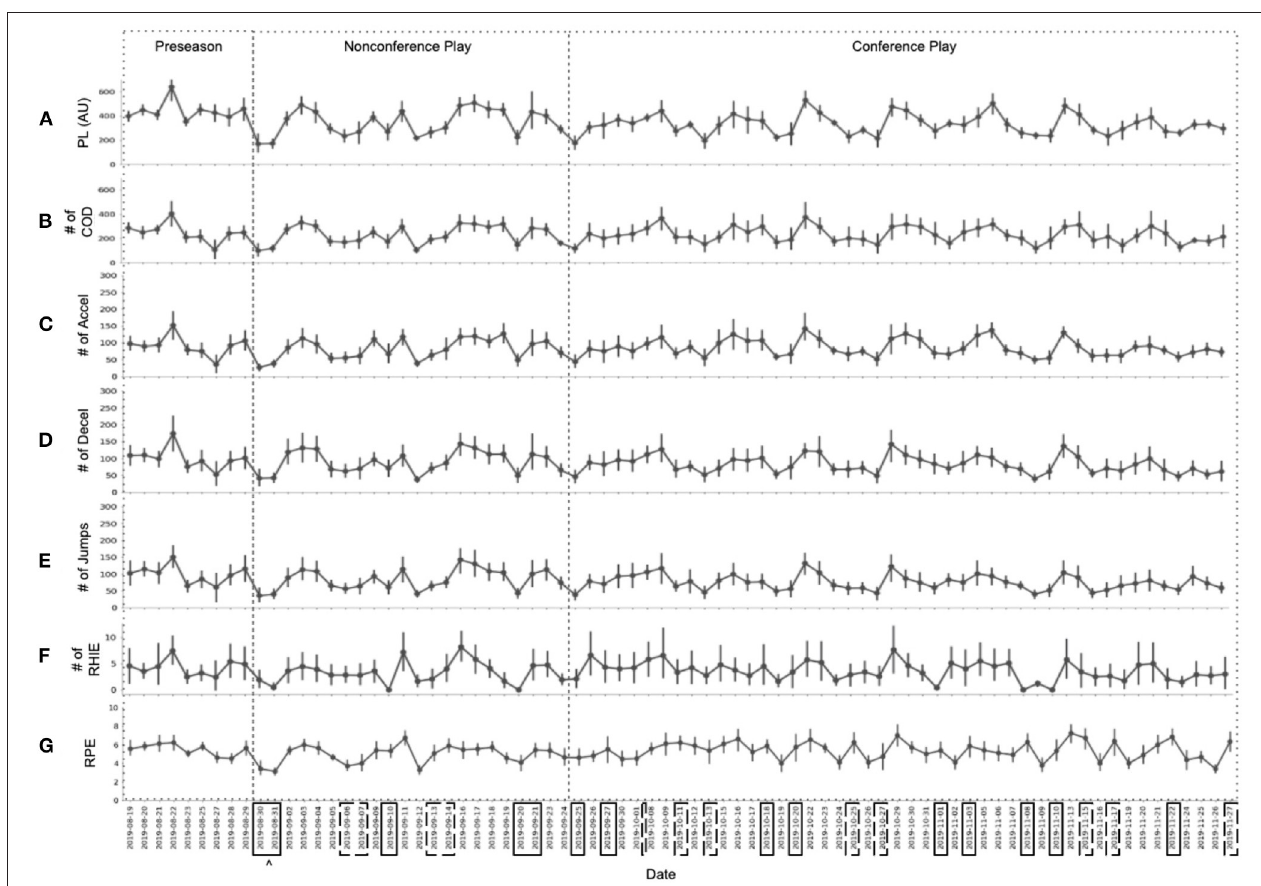
FIGURE 3 | Average Team Accelerometer Totals Over the Season. (A) Average playerload (PL); (B) Average number of change of directions (COD); (C) Average number of accelerations (accel); (D) Average number of decelerations (decel); (E) Average number of jumps; (F) Average number of repeated high-intensity efforts (RHIE); (G) Average rating of perceived exertion (RPE). Point estimates represent the mean team value for the specific date with error bars showing the 95% CI. ∧ Boxes around dates indicate values are from a game session with solid and dashed boxes denoting home and away games respectively.